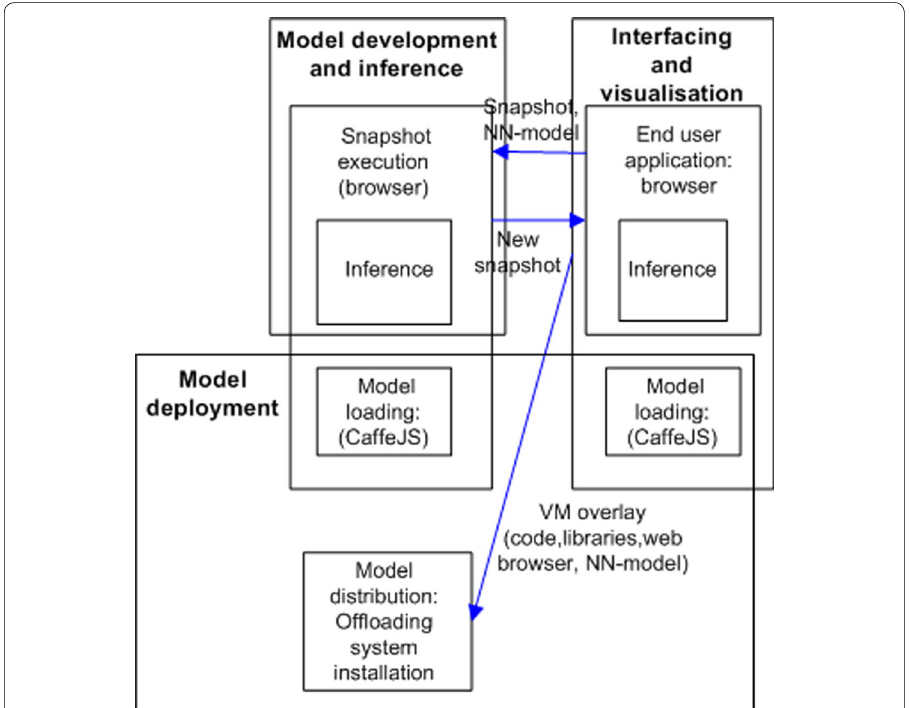
Fig. 6 The mapping of computation offloading architecture [27] to the big data